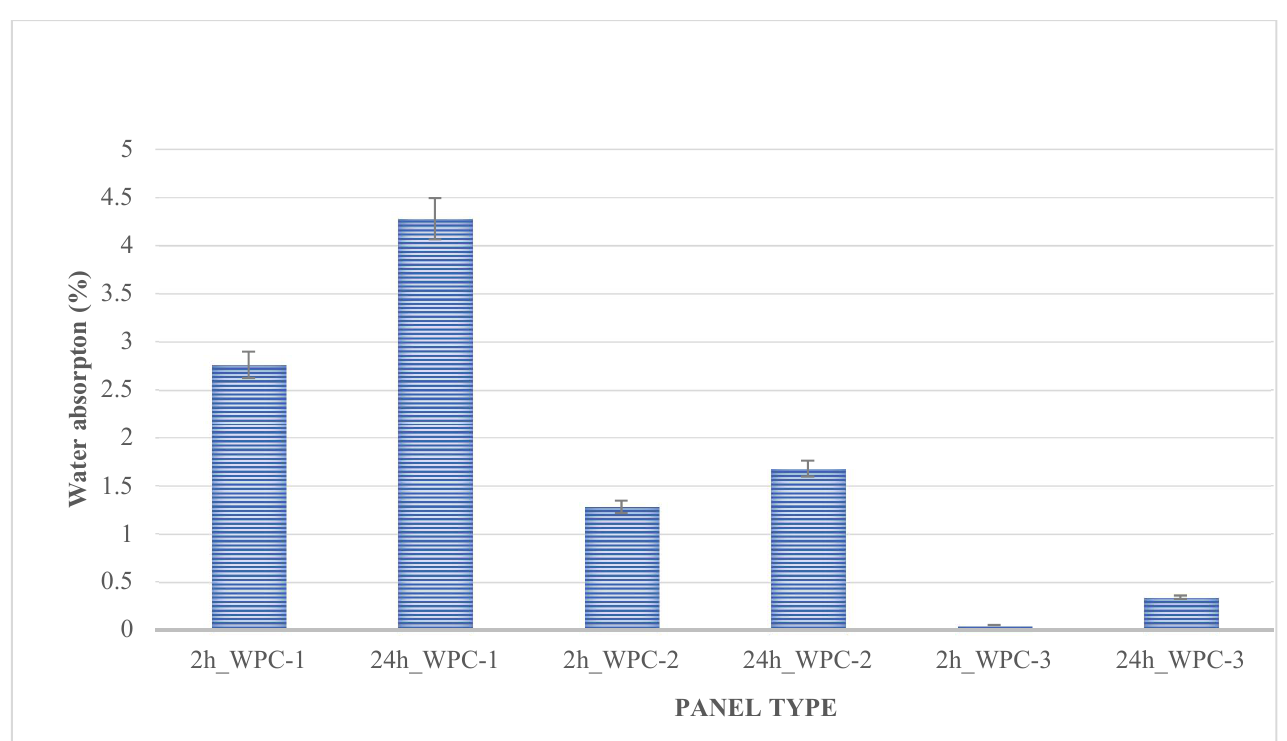
Figure 2. Surface of the water-soaked samples for 24-h: ( a ) WPC-1, ( b ) WPC-2, ( c ) WPC-3.